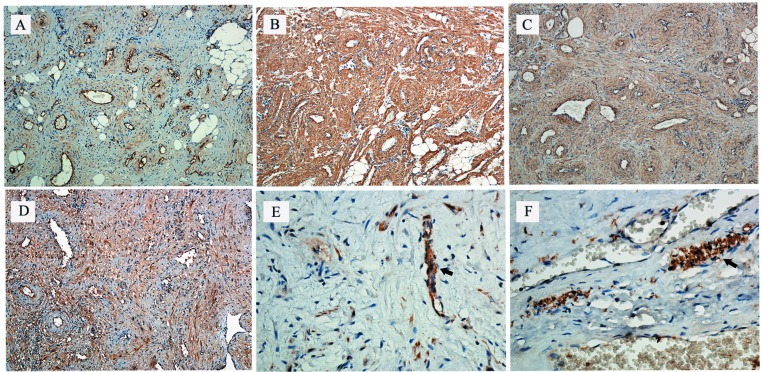
Immunohistochemical characteristics of head and neck angioleiomyoma. (A) Positive staining with anti-CD34 antibody exhibited by endothelial cells that lined the vascular spaces within the tumor (magnification, ×100). (B) Diffuse positive staining with anti-α-actin smooth muscle antibody showing spindle-shaped cells in smooth muscle cell bundles in the tumor (magnification, ×100). (C) Positive staining with anti-vimentin antibody showing expression in the cytoplasm of spindle-shaped cells (magnification, ×100). (D) Positive staining with anti-desmin antibody showing expression in the cytoplasm of neoplastic cells in ALM (magnification, ×100). (E) Positive staining with anti-S100 antibody showing nerve tissue near the capsule (black arrow; magnification, ×400). (F) Positive staining with anti-S100 antibody showing occasional tiny neurofibrils, closely associated with vessels (black arrow; magnification, ×400).